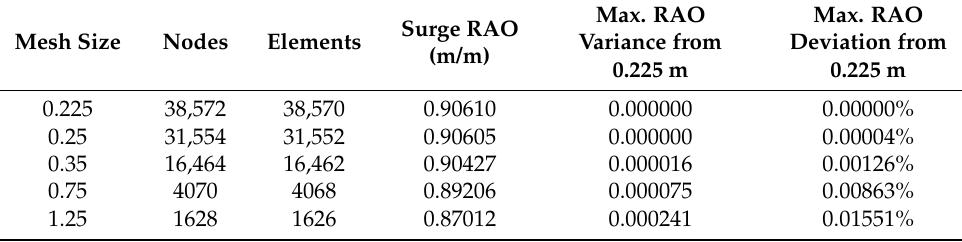
Figure 16. Convergence study on buoy using surge RAO (m). Table 11. Convergence study using surge